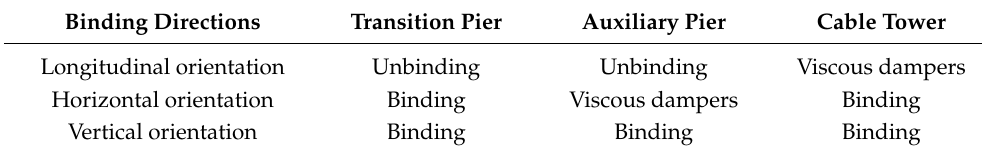
Table 4. The table of structural system constraints.